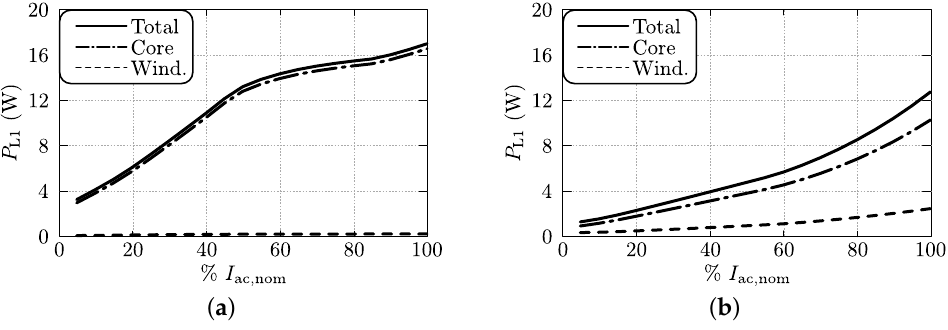
Figure B3. Calculated losses of the commutation inductor L 1 implemented according to ( a ) design “prot.” (prototype converter) and ( b ) the improved design “opt.” (further